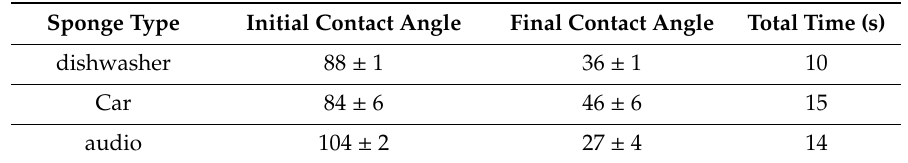
Table 5. Initial and final contact angle for 80% surfactant solution with 15dH water on each sponge type, where the total process time is also shown.